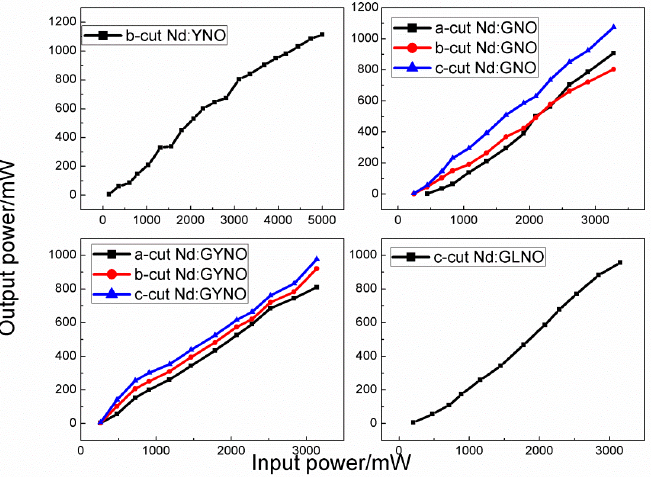
Figure 8. Laser output power of Nd:YNO, Nd:GNO, Nd:GYNO, and Nd:GLNO crystals versus incident power for different directions.